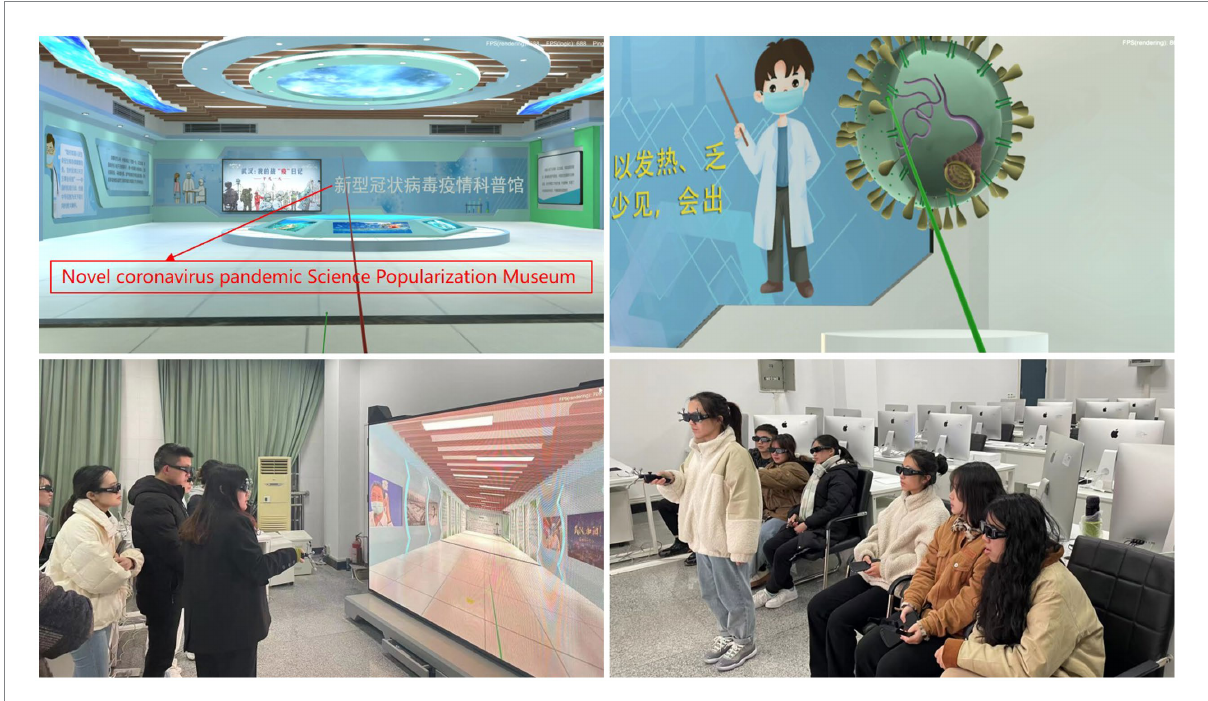
FIGURE 3 The IVR pandemic science museum simulation scenes and activities carried out map.